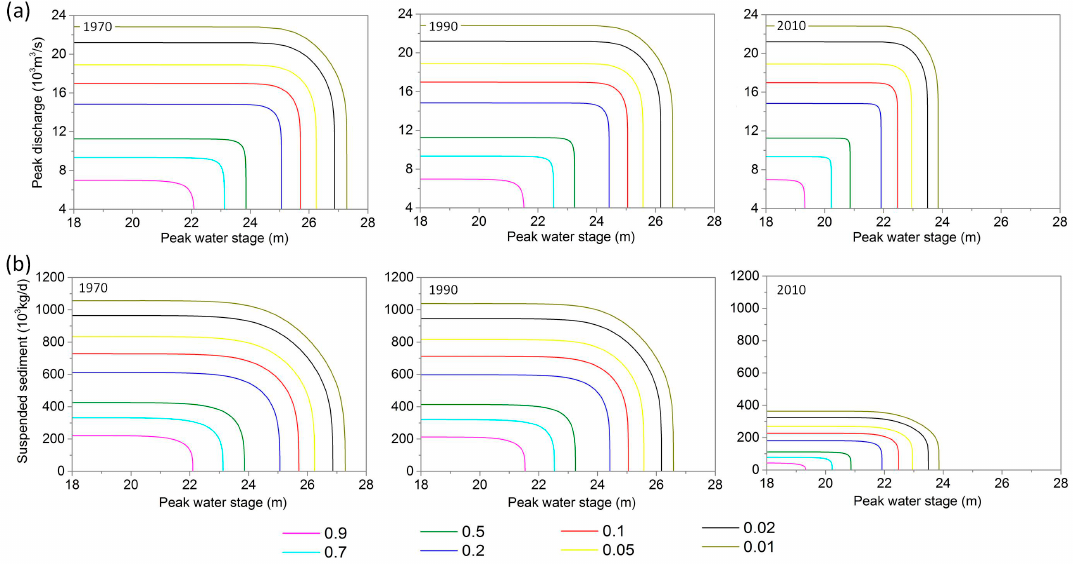
∧ Figure 5. Joint probability contours with the given P ∧ (AND) of Z-Q ( a ) and Z-S ( b ) using the best Figure 5. Joint probability contours with the given P (AND) of Z-Q ( a ) and Z-S ( b ) using the best fitted bivariate copulas at the Waizhou station in the years of 1970, 1990 and fitted bivariate copulas at the Waizhou station in the years of 1970, 1990 and 2010.